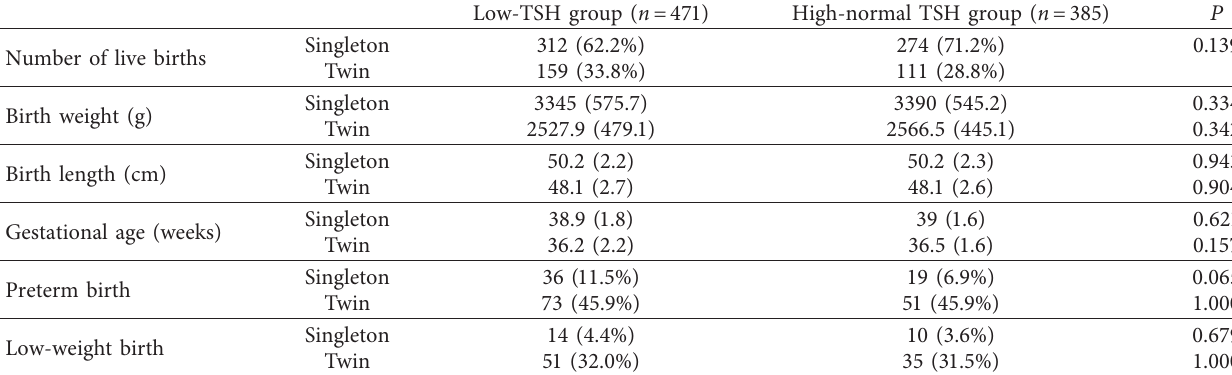
Table 4: The obstetric outcomes of the women undergoing the first fresh D3 embryo